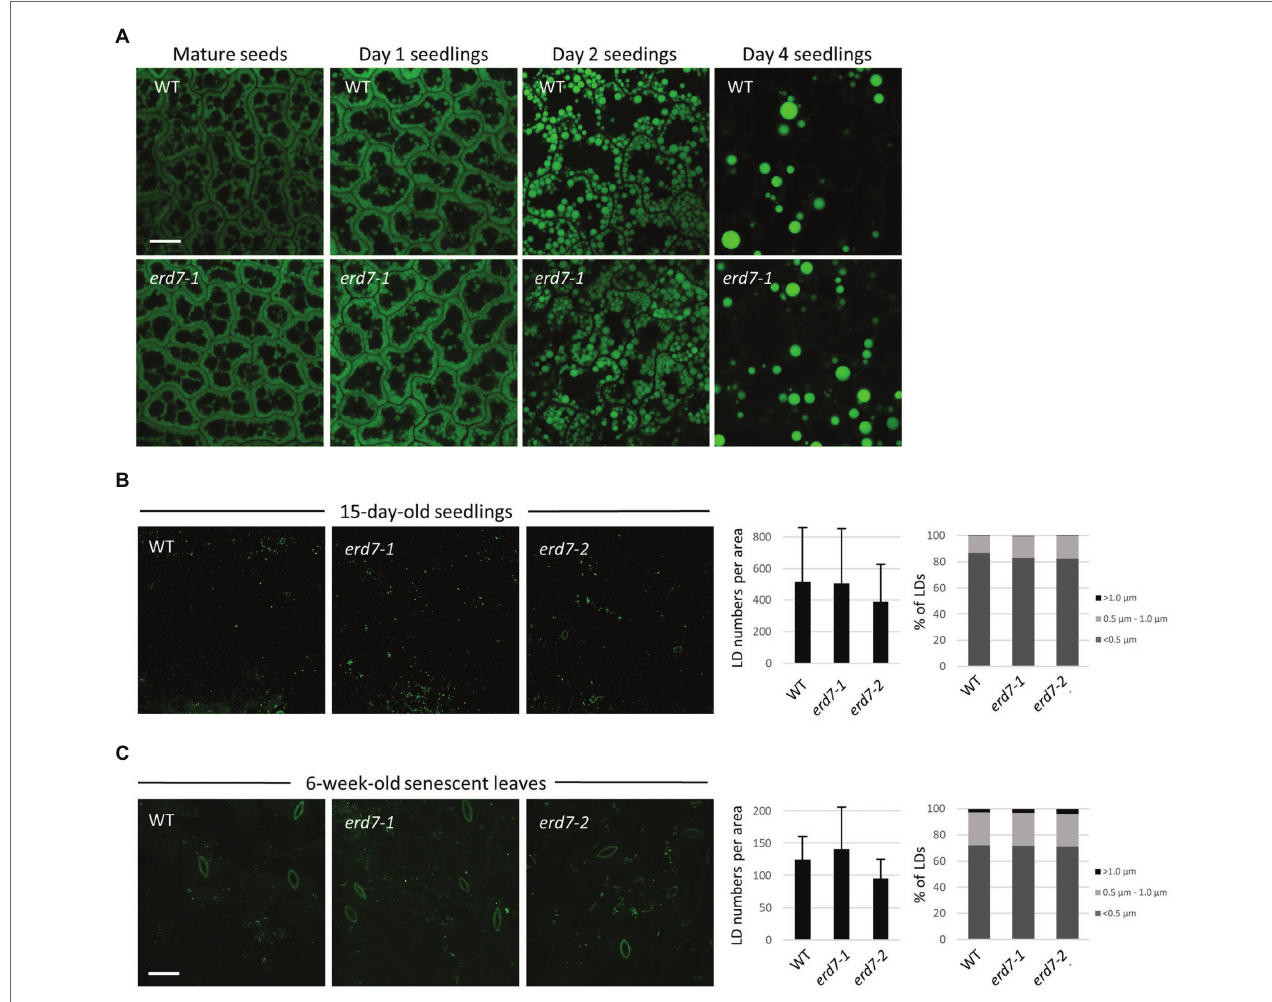
FIGURE 5 | ERD7 does not appear to be required for regulating LD numbers and sizes in Arabidopsis under normal growth conditions. Shown are representative CLSM images of BODIPY-stained LDs in leaf epidermal cells of (A) embryo cotyledon cells in mature (dry) seeds and germinating seedlings either 1, 2, or 4 days after germination; (B) 15-day-old Arabidopsis seedlings; and (C) 6-week-old, senescent Arabidopsis plants, from WT and erd7-1 and/or erd7-2 mutant lines, as indicated by labels. Scale bar = 20 μ m. Shown also in (B,C) in the graphs on the right are the quantifications of LD numbers per area and LD sizes. Values of LD numbers in (B) are averages ± SD from three biological replicates, with each replicate consisting of two leaf samples from 3–4 plants per line. Values of LD numbers in (C) are averages ± SD from two biological replicates of 10 plants per line. LD diameters were calculated using the same data set (i.e., micrographs) and are presented as the percentage of LDs in three size classes: <0.5 μ m (small), 0.5–1.0 μ m (intermediate), and >1.0 μ m (large); refer also to key. Overall, there were no significant differences in either LD numbers per area or LD sizes in leaves of 15-day-old seedlings or 6-week-old (senescing) plants from WT and both the erd7-1 and erd7-2 mutant lines, based on Student’s t -tests ( p ≤ 0.05). Similarly, based on images presented in (A) and others, no obvious qualitative differences in LD numbers or sizes were observed between WT and erd7-1 mutant seeds and